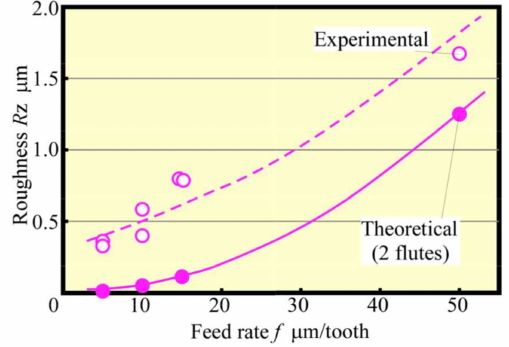
Figure 10. Relationship between roughness and feed rate (Up cut, N s = 100,000 min − 1